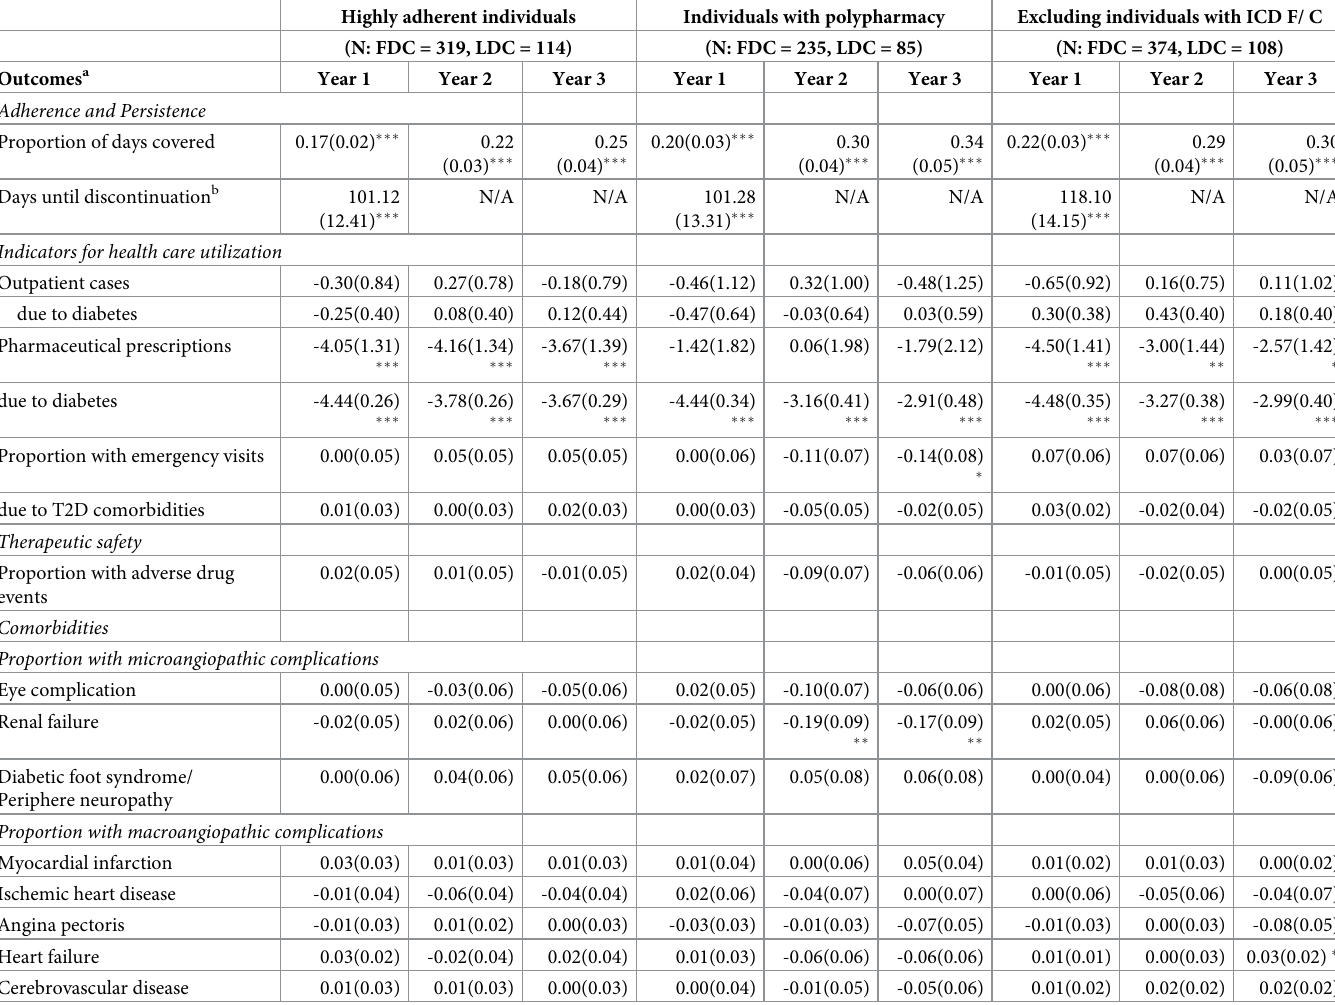
Table 3. Difference-in-difference regression results for